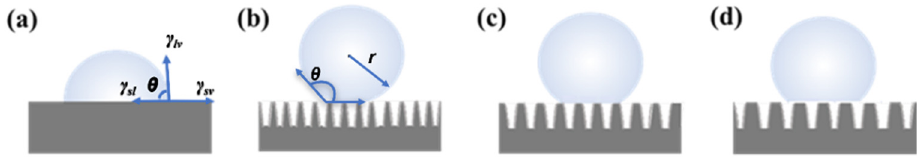
Figure 8. Schematic of a droplet on different surfaces ( a ) pristine, ( b ) fine grids, ( c ) middle grids, and ( d ) large grids.